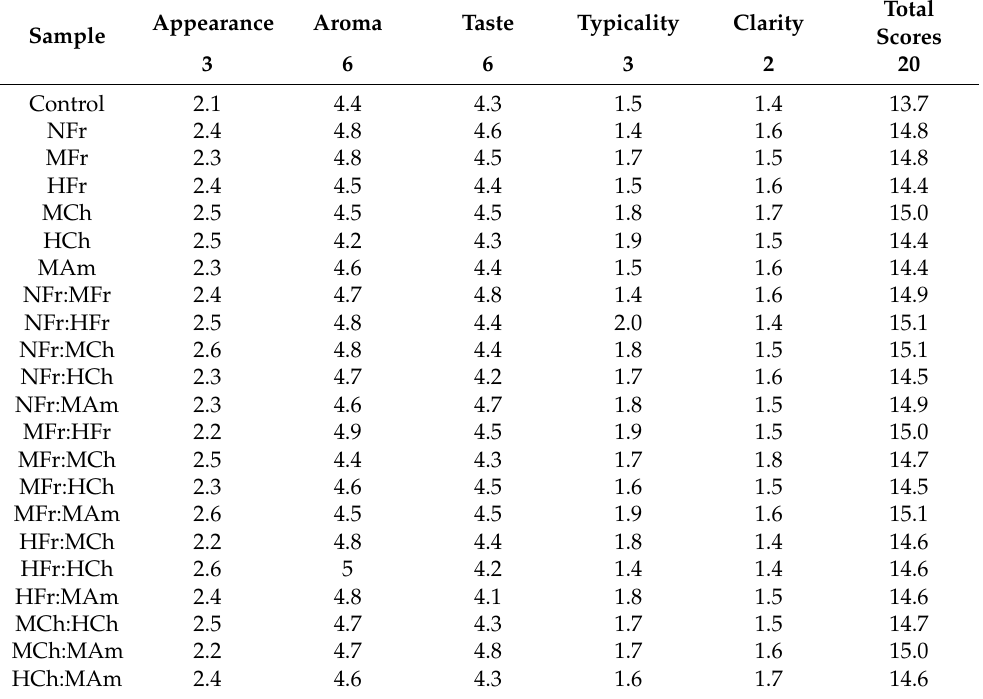
Table 6. Sensory evaluation of wines after oak chip